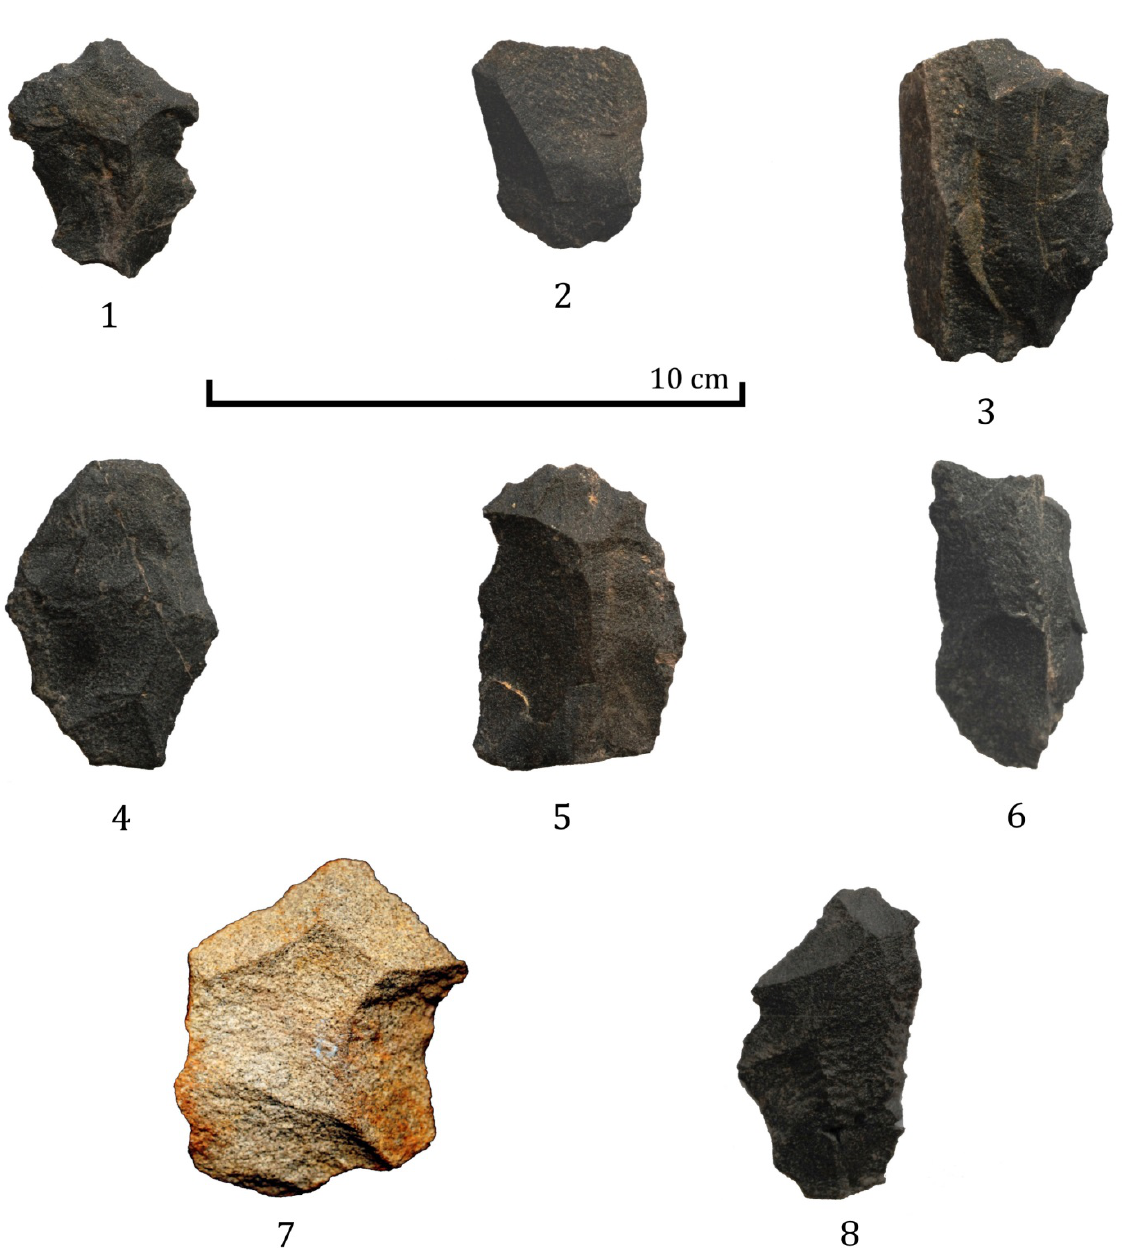
Figure 6. 1, 4-8: Quartzite Levallois flakes; 2: Quartzite discoid flake; 3: Quartzite side